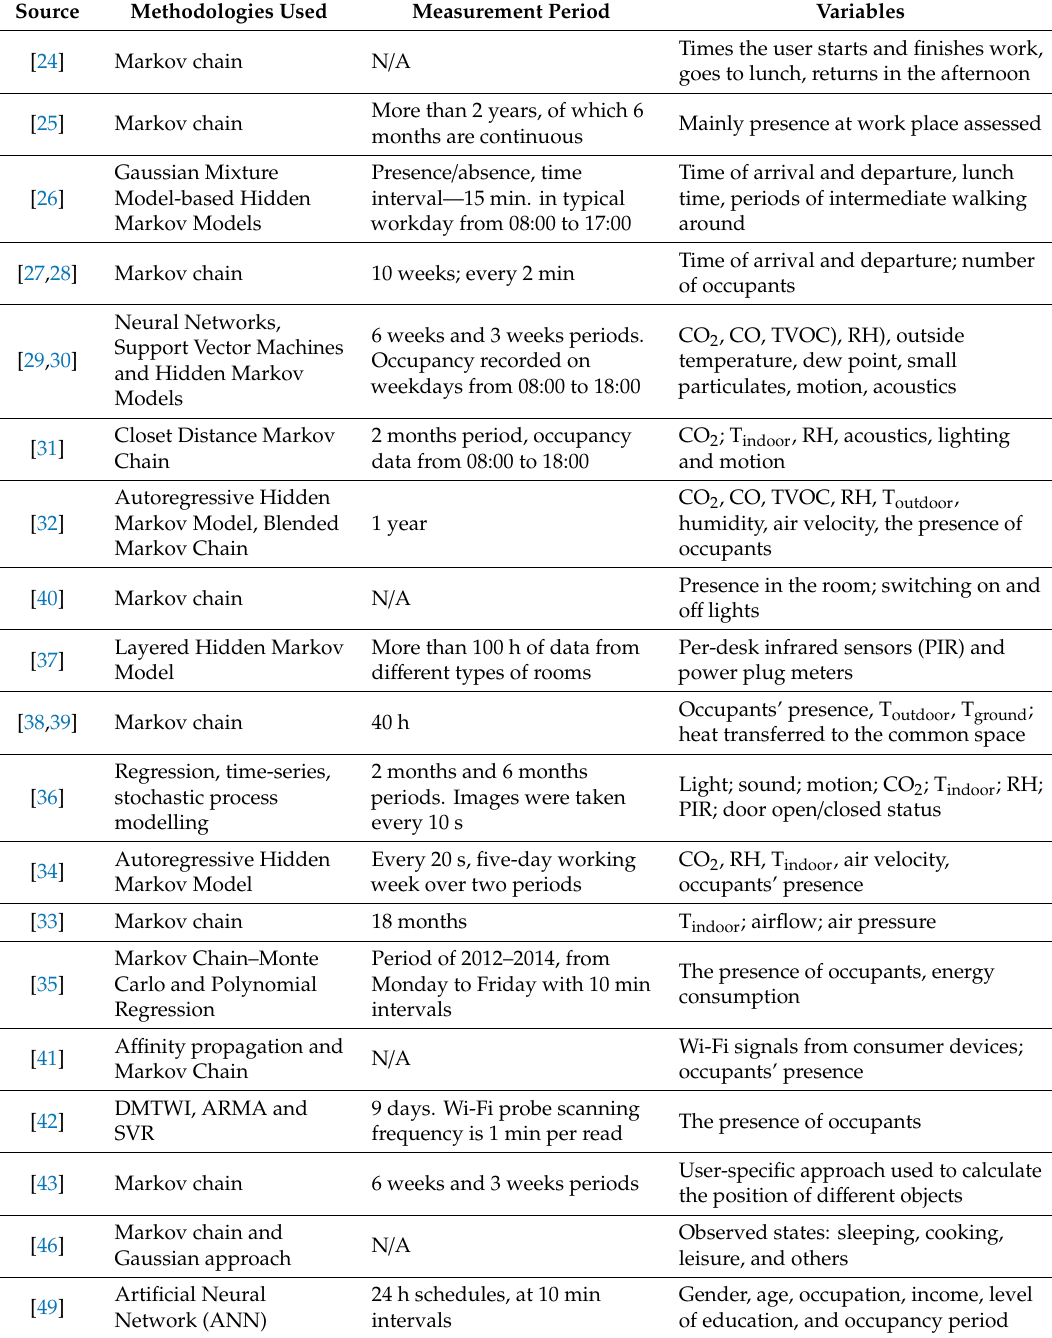
Table 1. Previous studies on occupancy measurements and occupancy profile